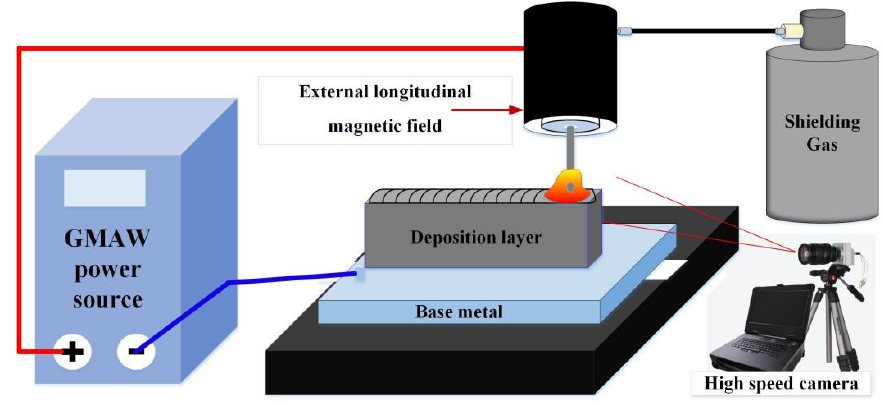
Figure 1. Schematic diagram of the M-GMAW-AM system. The fixed parameters are the voltage (19 V). The parameter variable contains wire feeding speed (2–4 m/min) and magnetic excitation current (1–3 A). The wire feeding speeds of 2 m/min, 3 m/min, and 4 m/min respectively correspond to the welding current of 150A, 165A, and 180A. The detail parameters of Ti-6Al-4V alloy in M-GMAW-AW are given in Table 1. Table 1. Parameters of Ti-6Al-4V alloy in M-GMAW-AW. No.